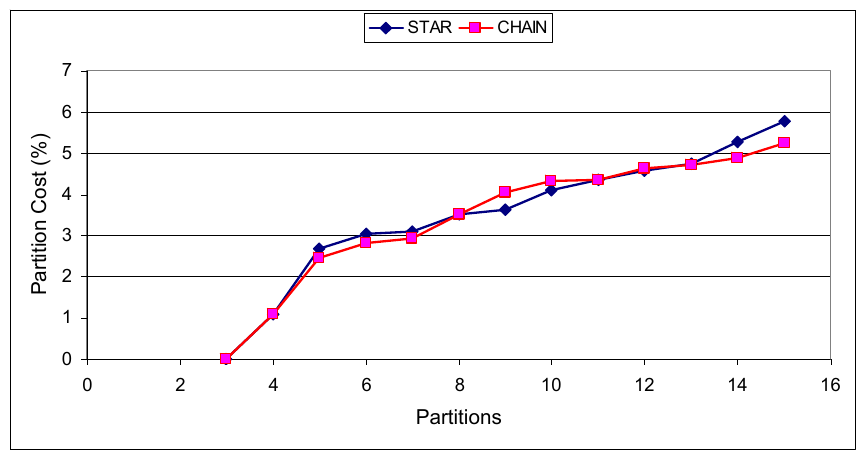
Figure 9. Partitioning cost as function of the number of equal sizes partitions, for WL1 workload using CHAIN and STAR topology.